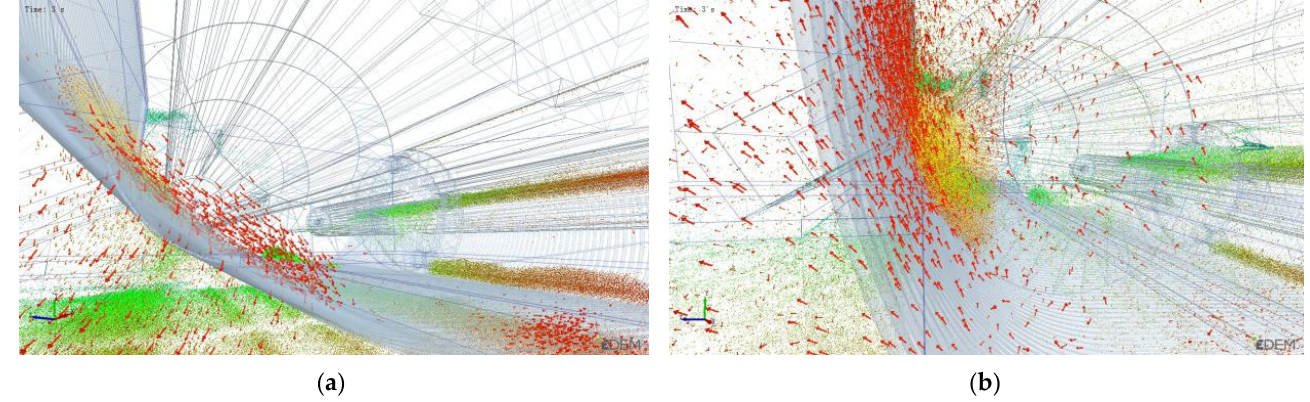
Figure 11. Position simulation comparison diagram: ( a ) sandy soil removal process without vibratory action; ( b ) sandy soil removal process with vibratory action.